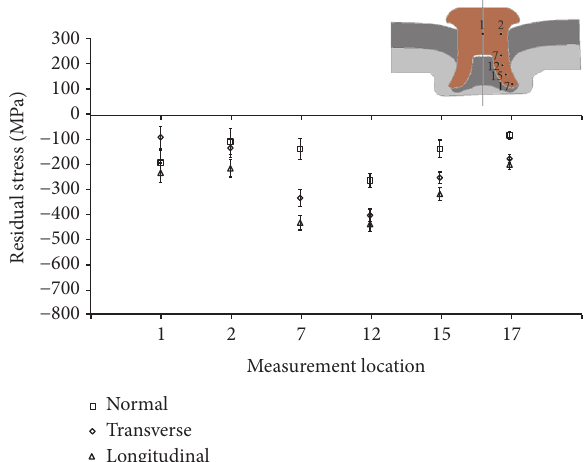
Figure 14: Distribution of residual stress in the rivet of joint II.